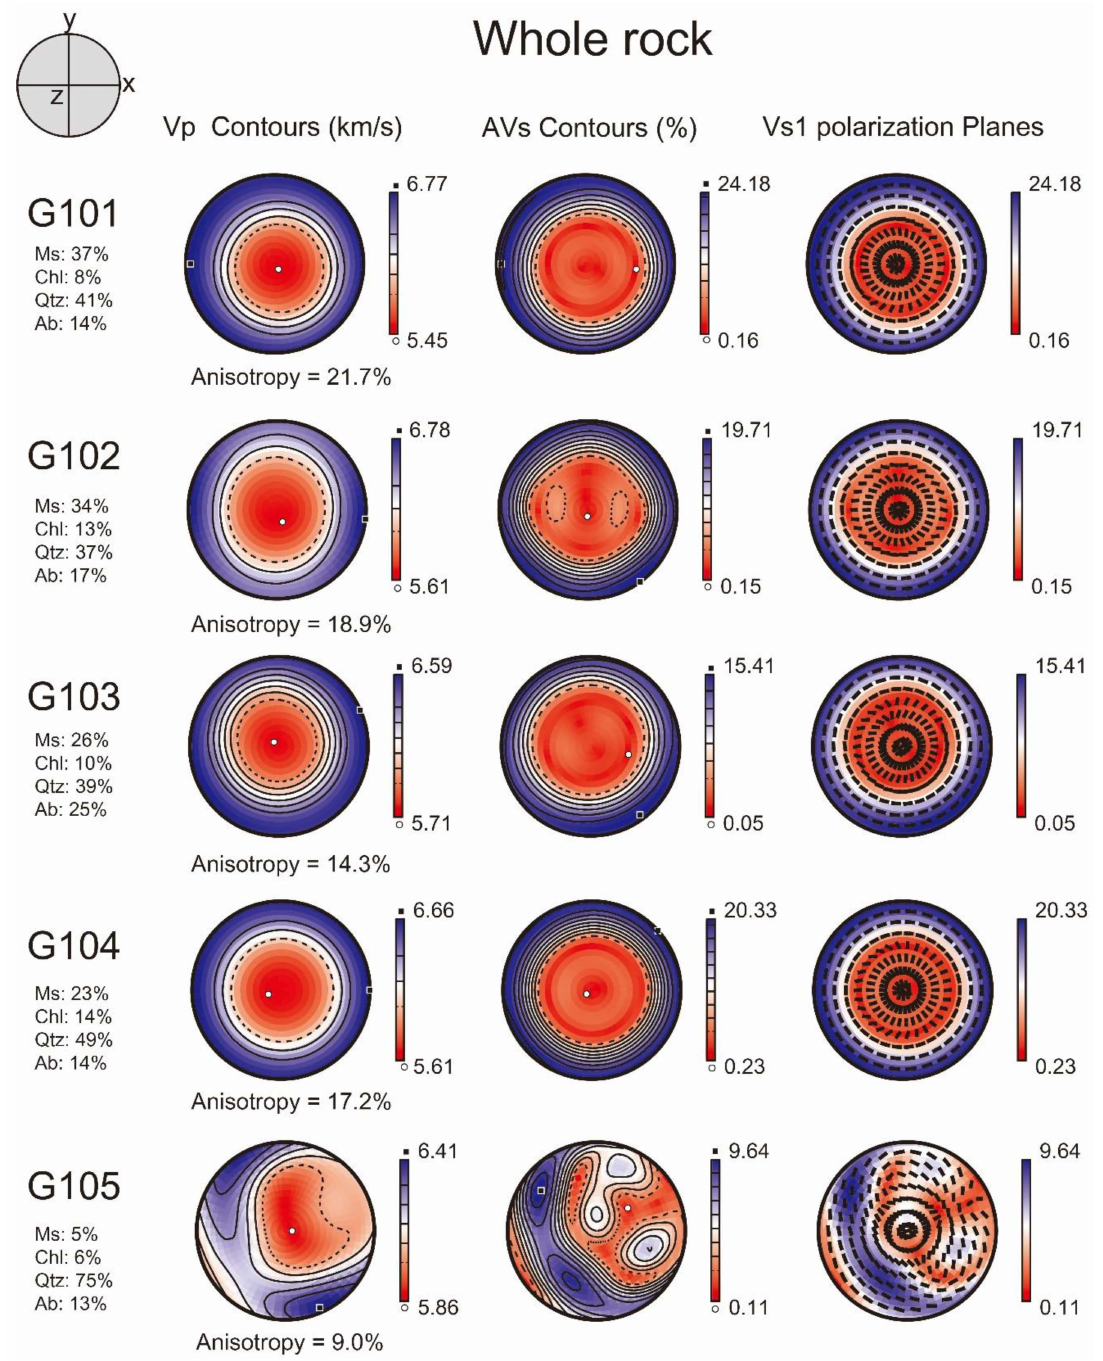
Figure 10. Whole rock seismic properties calculated from LPOs, volume proportions and elastic constant of each minerals. The P-wave velocity (Vp), amplitude of the shear-wave anisotropy (AVs), and polarization direction of the faster shear wave (Vs1) are plotted in the lower hemisphere using an equal-area projection. E–W direction of each figure corresponds to stretching lineation (X), and Z is normal to the